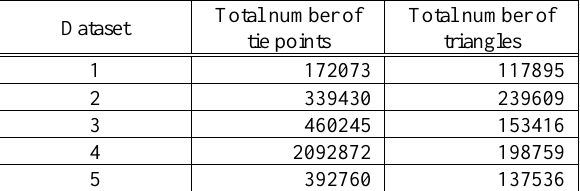
Table 5. Number of tie point and TIN generated by the proposed